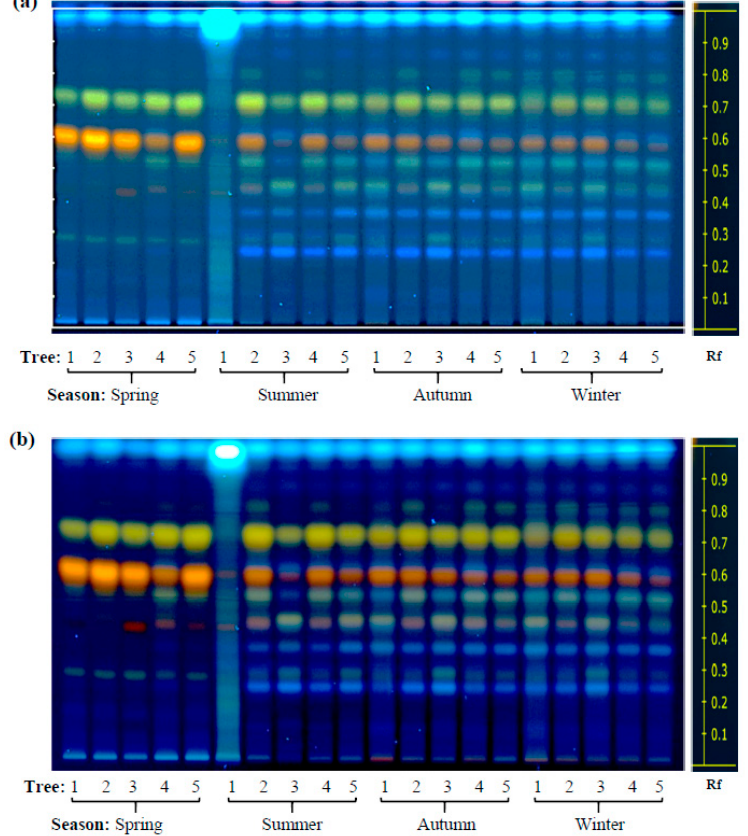
Figure 1. Seasonal variation in the content of phenolic secondary metabolites in Diospyros rekoi . High performance-thin layer chromatography (HP-TLC) traces of D. rekoi leaf extracts visualized under ( a ) UV light (254 nm) and ( b ) UV light (366 nm) after derivatization with the NP / PEG reagent. Lanes: 1–5 represent leaf extracts from five trees (1–5) that were systematically sampled in the spring, summer, autumn, and winter of 2014. Band Rf values are represented on the right-side end of the